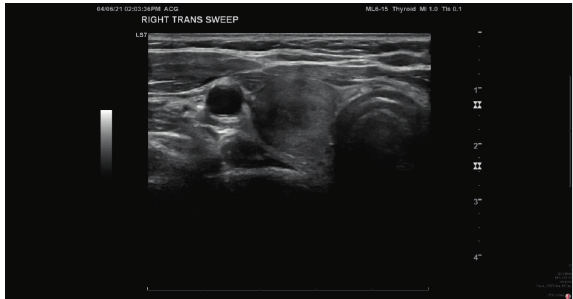
Figure 1: Ultrasound of the right thyroid lobe showing a het- erogeneous mass.